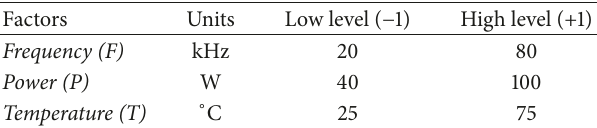
Table 1: Independent variables and their coded levels used in RSM studies for USA